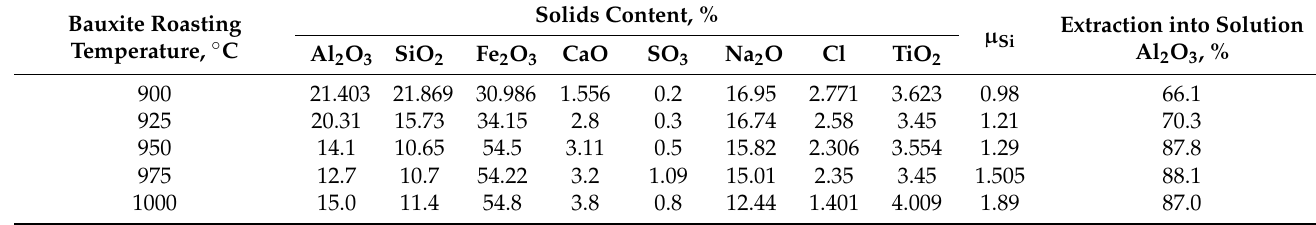
Table 3. The compositions of solid phases (red mud) with µ Si and Al 2 O 3 extraction. Table 2. The compositions of aluminate solutions (with α к y and μ Si ).